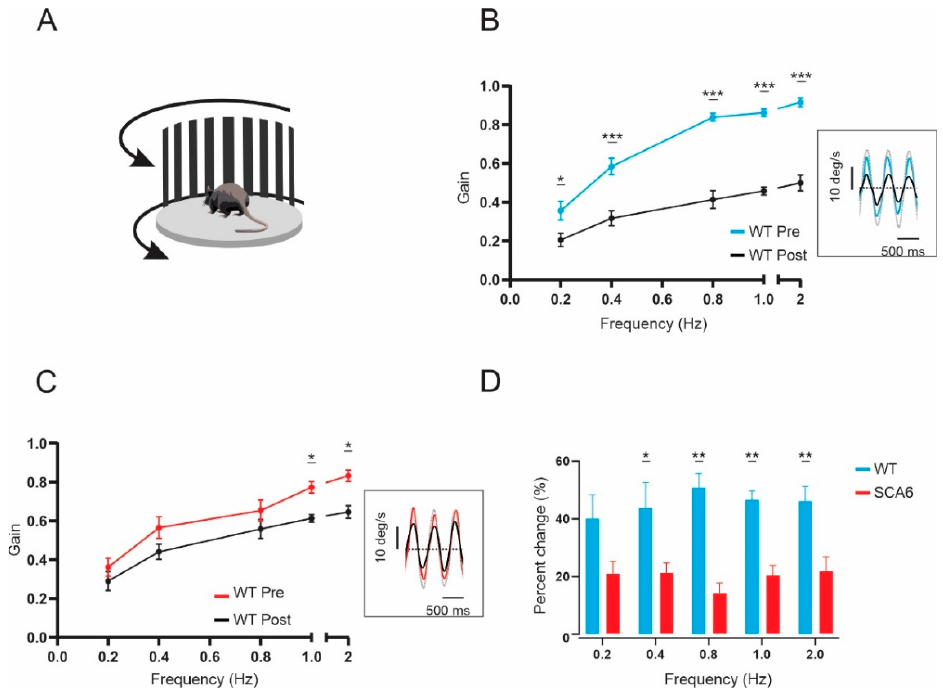
Figure 3. VOR learning is impaired in SCA6 84Q mice. ( A ) Schematic of the experimental setup. ( B ) VORd gain (mean ± SEM) before and after the VOR gain-down training plotted as a function of frequency for wild-type (WT) mice ( n = 6). Inset, example of eye- and head-velocity (grey) traces before (blue) and after training (black) at 2 Hz ( C ) VORd gain (mean ± SEM) before and after the VOR gain-down training plotted as a function of frequency for SCA6 84Q mice ( n = 7). Inset, example of eye- and head-velocity (grey) traces before (red) and after training (black) at 2 Hz ( D ) Percent change in VOR gain for WT and SCA6 84Q mice. Comparisons were made with two-way repeated measures ANOVA with post hoc Bonferroni’s test. * p < 0.05, ** p < 0.01, *** p < 0.001.